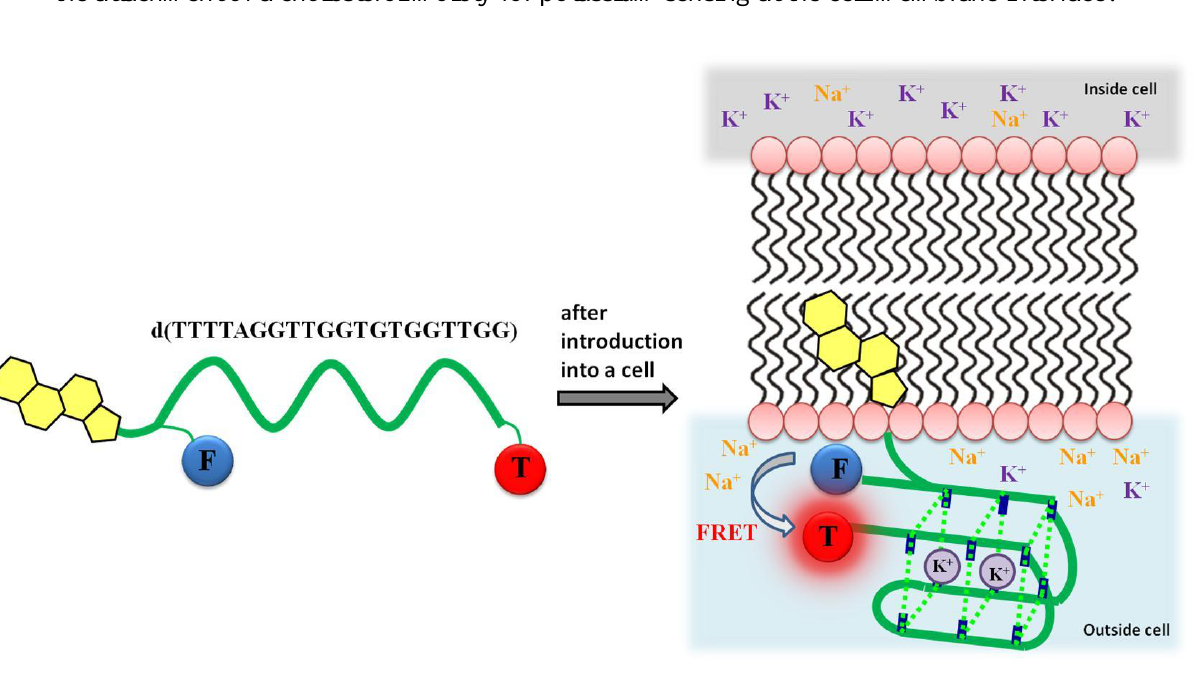
Scheme 1. Concept showing the model of fluorescent oligonucleotide probes modified by the attachment of a cholesterol moiety for potassium sensing at the cell membrane